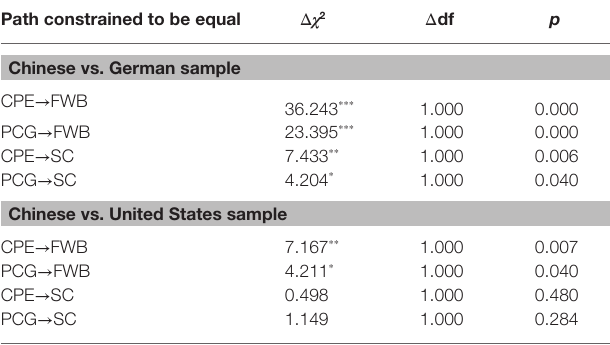
TABLE 7 | Model comparison results of multigroup